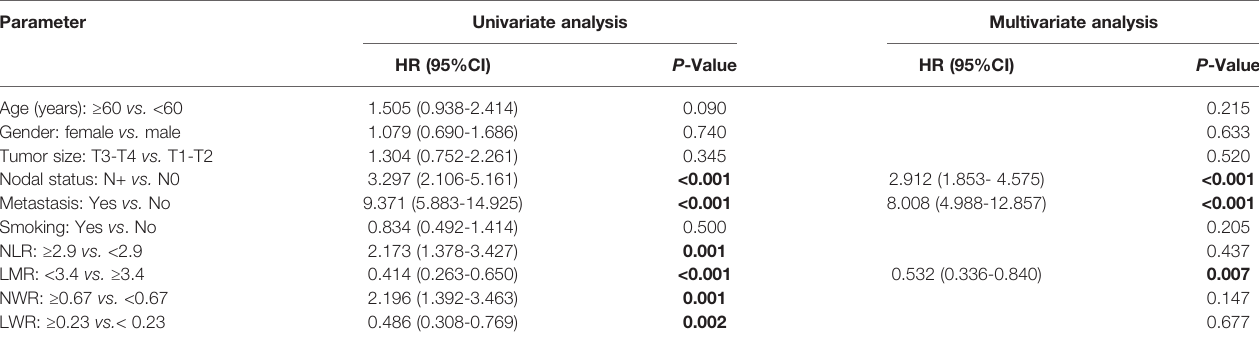
TABLE 3 | Univariate and multivariate analysis for